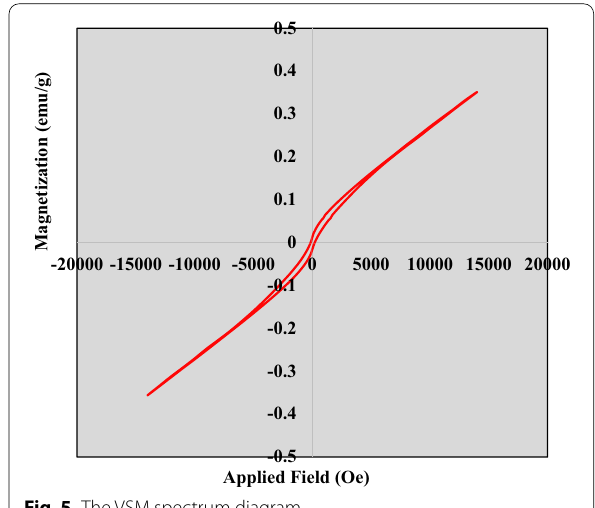
Fig. 5 The VSM spectrum diagram